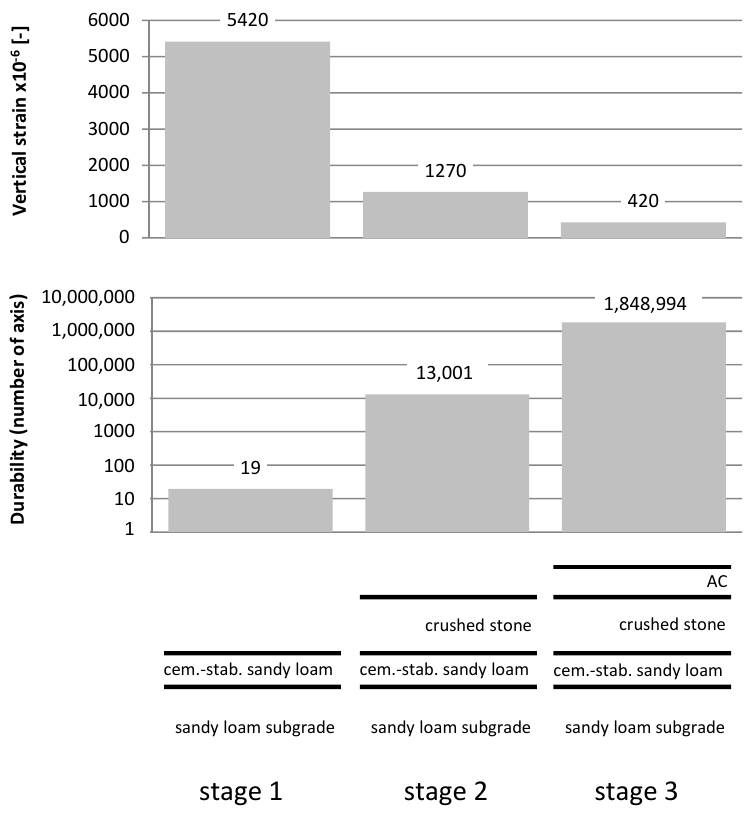
Figure 16. Distribution of vertical stresses in exploited systems at various